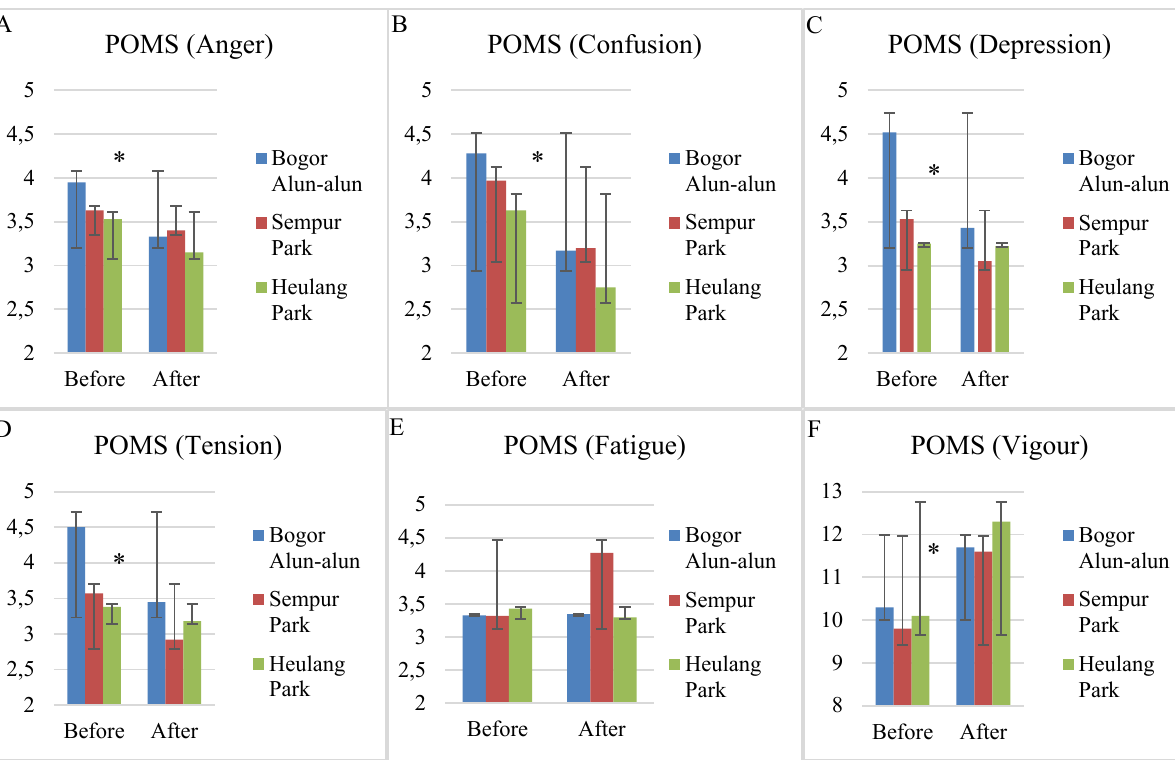
Figure 4. Comparison of the results of the POMS subscale and before and after walking experiment in the three locations. (A) Anger. (B) Confusion. (C) Depression. (D) Tension. (E) Fatigue. (F) Vigour. Note: (*) p - value ≤0